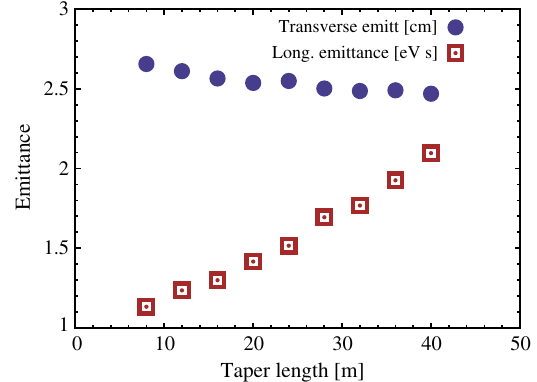
FIG. 10. Transverse and longitudinal emittances of the muon beam at the end of decay channel as a function of the solenoid taper length, for the same simulations used in Fig.